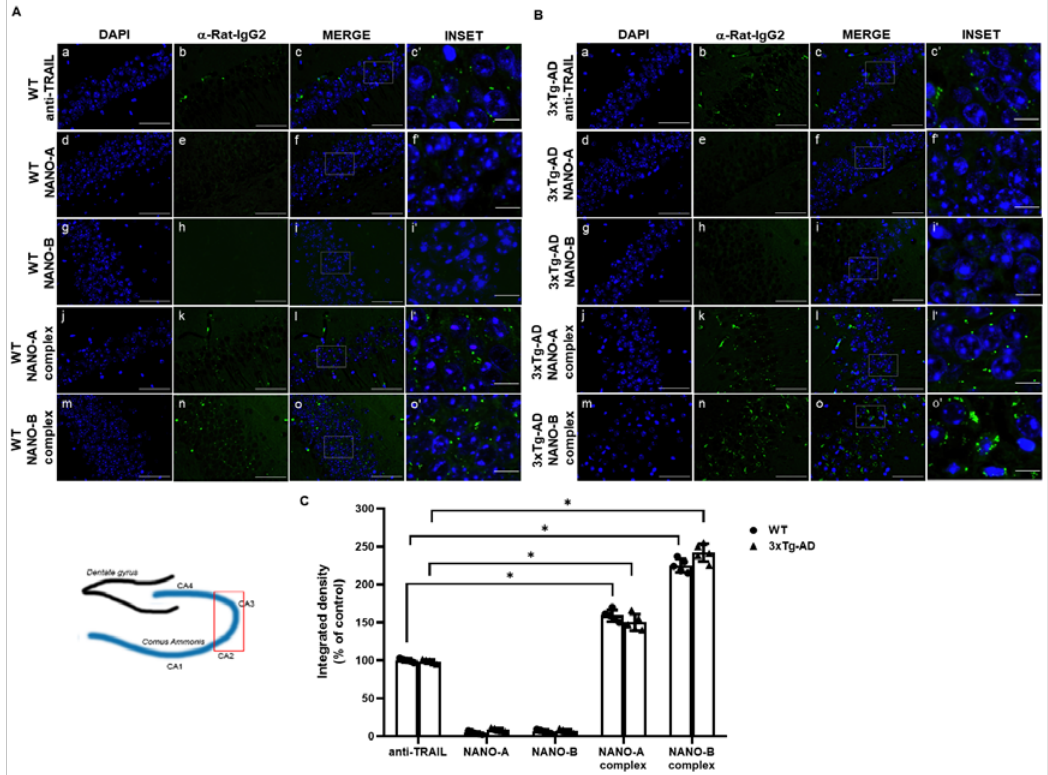
Figure 5. Comparison of polymeric or lipidic nanoparticles complexed with anti-TRAIL in the hip- pocampus of 3xTg-AD mice after intranasal administration. Representative immunofluorescence microscopy images showing the localization of anti-TRAIL monoclonal antibody in the hippocampal sections from WT ( A ) or 3xTg-AD ( B ) mice intranasally administered for 24 h with anti-TRAIL monoclonal antibody, empty or anti-TRAIL loaded NANO-A, NANO-B nanoparticles. Fluorescence signal was detected by using a fluorescent secondary anti-rat IgG. ( C ) Densitometric count of fluores- cence was performed with the aid of ImageJ software (Available online: https://imagej.nih.gov/ij/ (accessed on 12 January 2022)) and represented as integrated density (% of control). Data are ex- pressed as mean ± SD. One-way ANOVA followed by the Fisher’s LSD test were used for statistical analysis. * p < 0.05. (a–o scale bar = 50 µ m; c’,f’, I’, l’, o’ scale bar = 10 µ